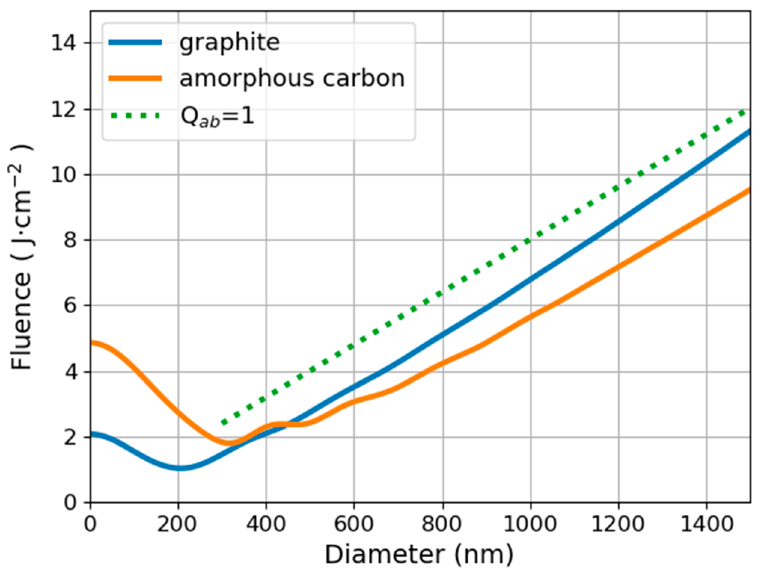
Figure 1. Threshold fluence necessary for the evaporation of spherical carbon particles in water by a laser beam with a wavelength of 1064 nm.